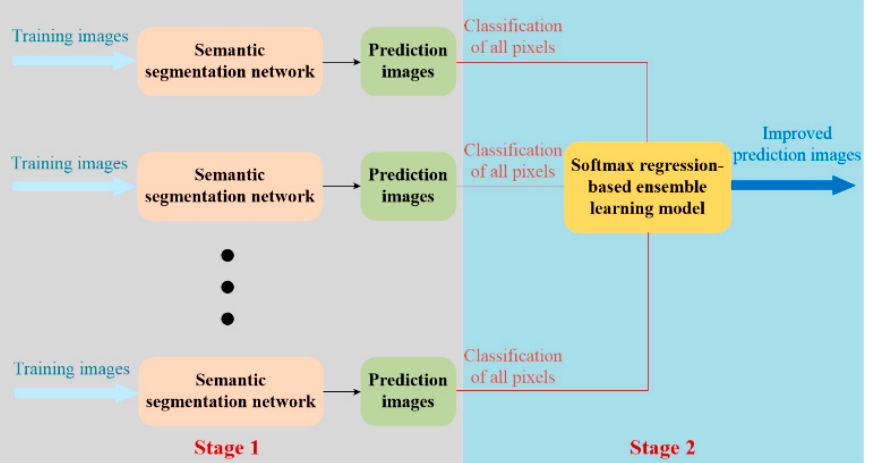
Figure 1. Concept diagram of performance improvement strategy for concrete damage detection using stacking ensemble learning of multiple semantic segmentation networks.